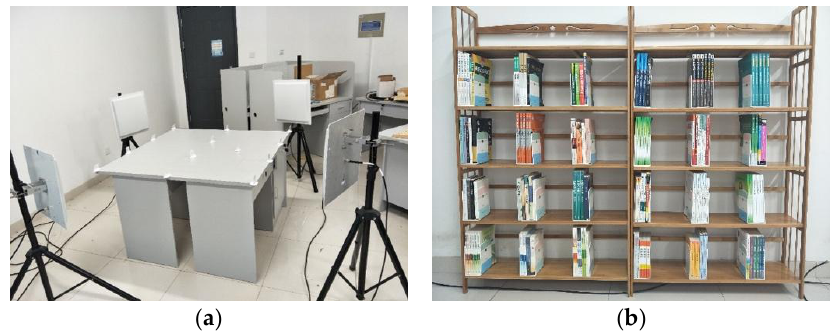
Figure 2. Experimental scenario. ( a ) Regional division scenario; and, ( b ) Bookshelf test scenario